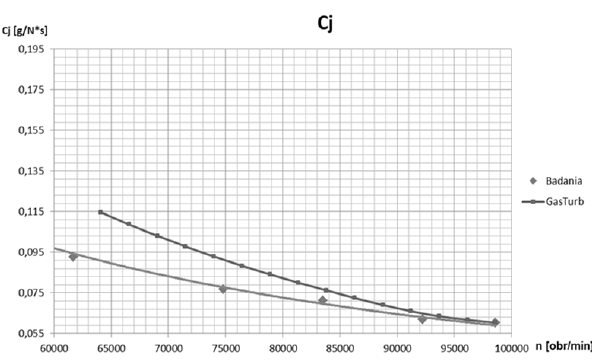
Fig. 7. Specific fuel consumption as a function of engine rotational speed